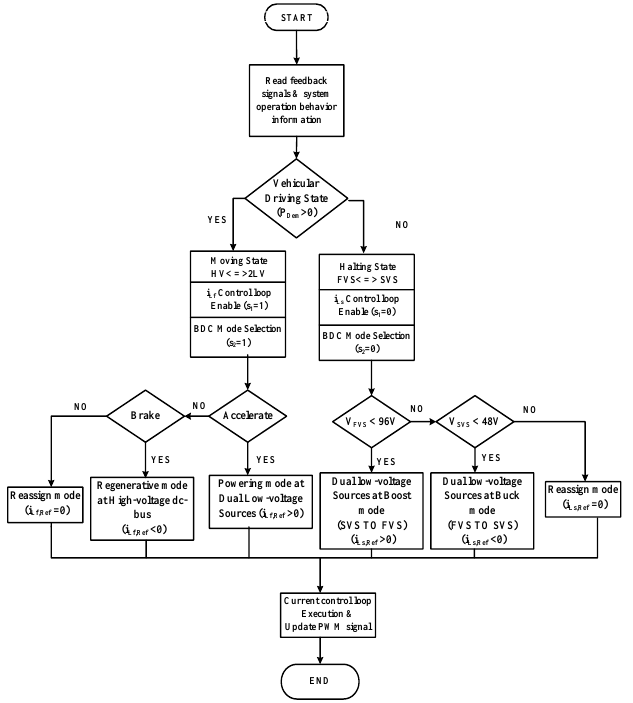
Figure 11. Flowchart for the planned BDC’s multiple working modes.